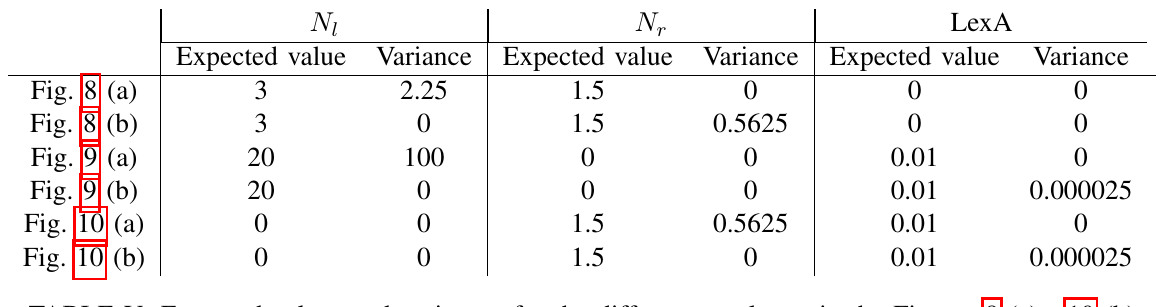
TABLE V: Expected values and variances for the different regulators in the Figures 8 (a) - 10 (b)